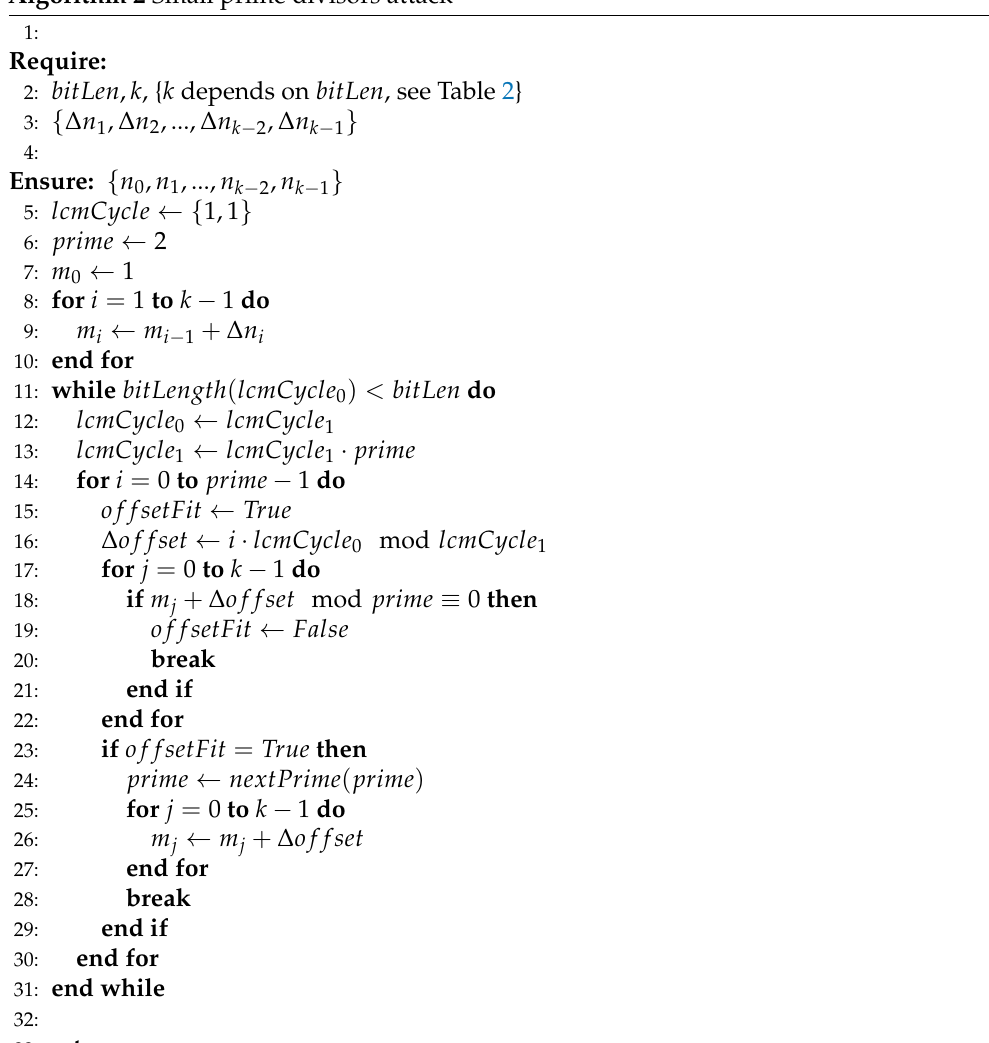
Algorithm 2 Small prime divisors